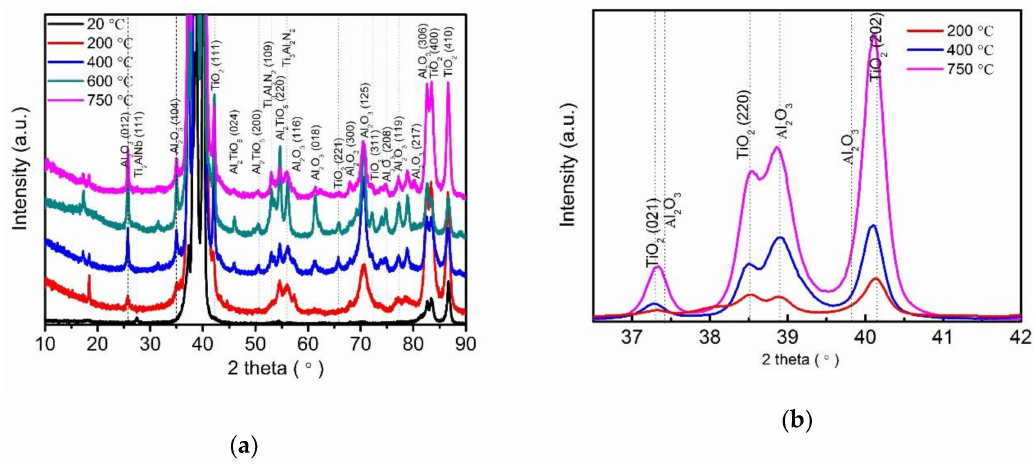
Figure 8. XRD patterns of the alloy vs. Al 2 O 3 at different temperature ( a ) the overall picture ( b ) the local picture.